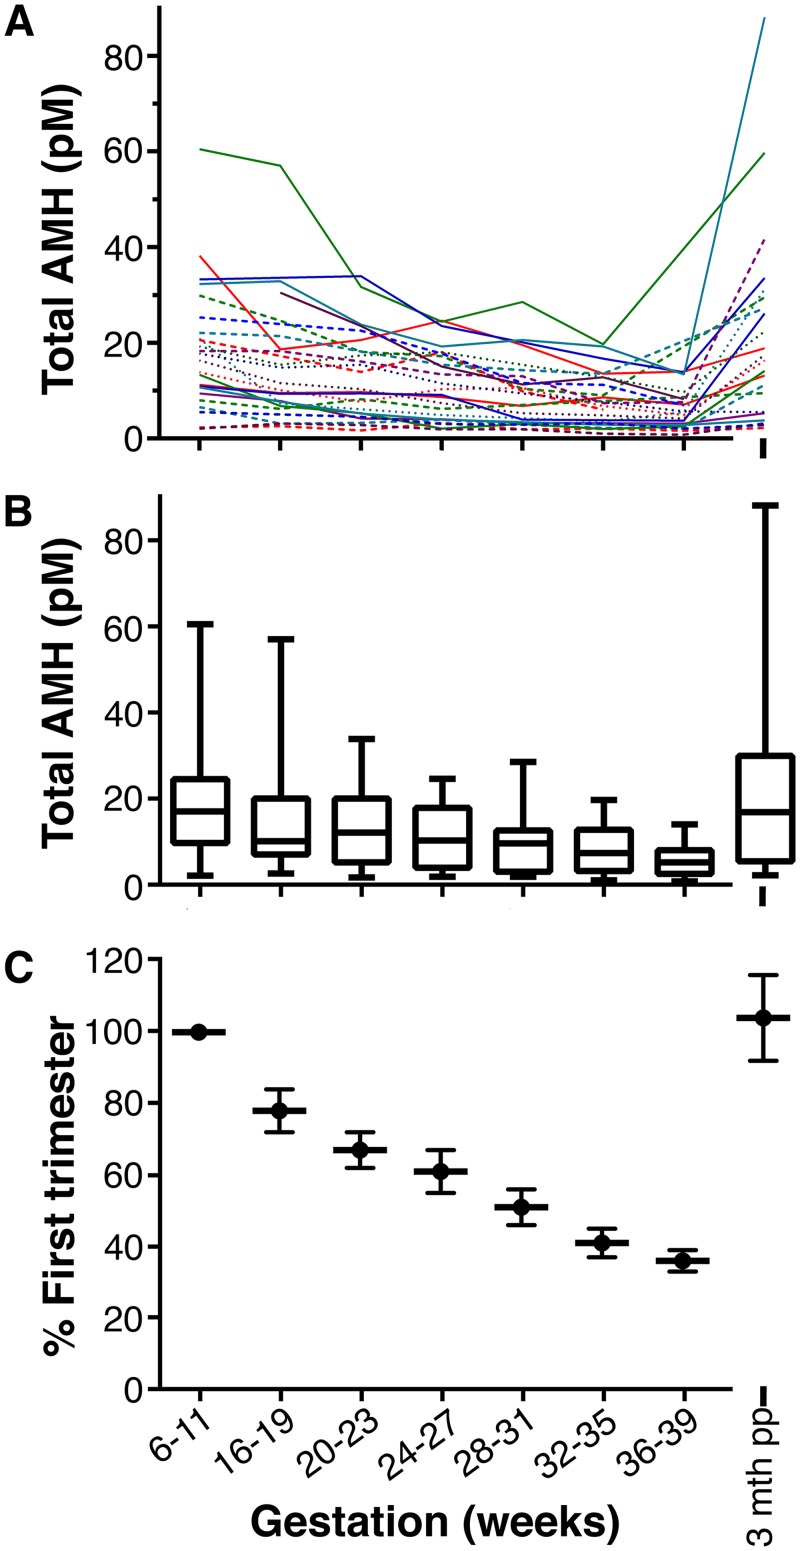
Change in total AMH levels during gestation.(A) Each woman’s individual levels are shown. (B) Box and whisker plots (medians, interquartile intervals, range) of AMH levels. (C) Percentage decline. Each woman’s values were normalized to her first trimester (6–11 weeks) sample, using log transformation. The data is the mean ± standard of error of the mean. There is a significant decline with gestational age, p<0.001 (repeated measures, mixed model). LSD post-hoc analysis indicated that all time points were significantly different compared to the 6–11 week samples (p = 0.026 for the 16–19 week time-point and p < 0.001 for the other gestational ages). 1 ng/ml of AMH = 7.14 pmol/L (pM).